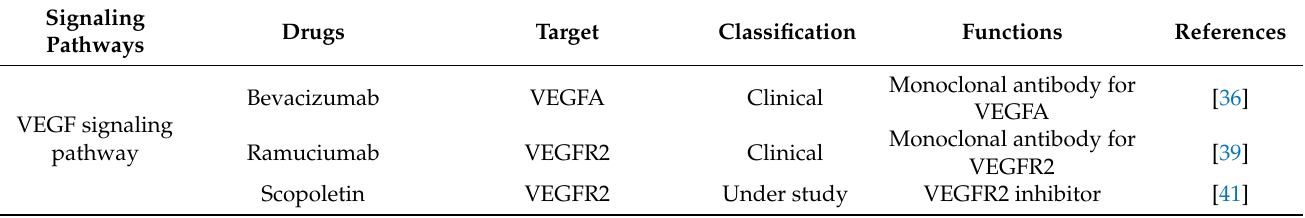
Table 1. Existing/potential drugs with anti-angiogenic effects in